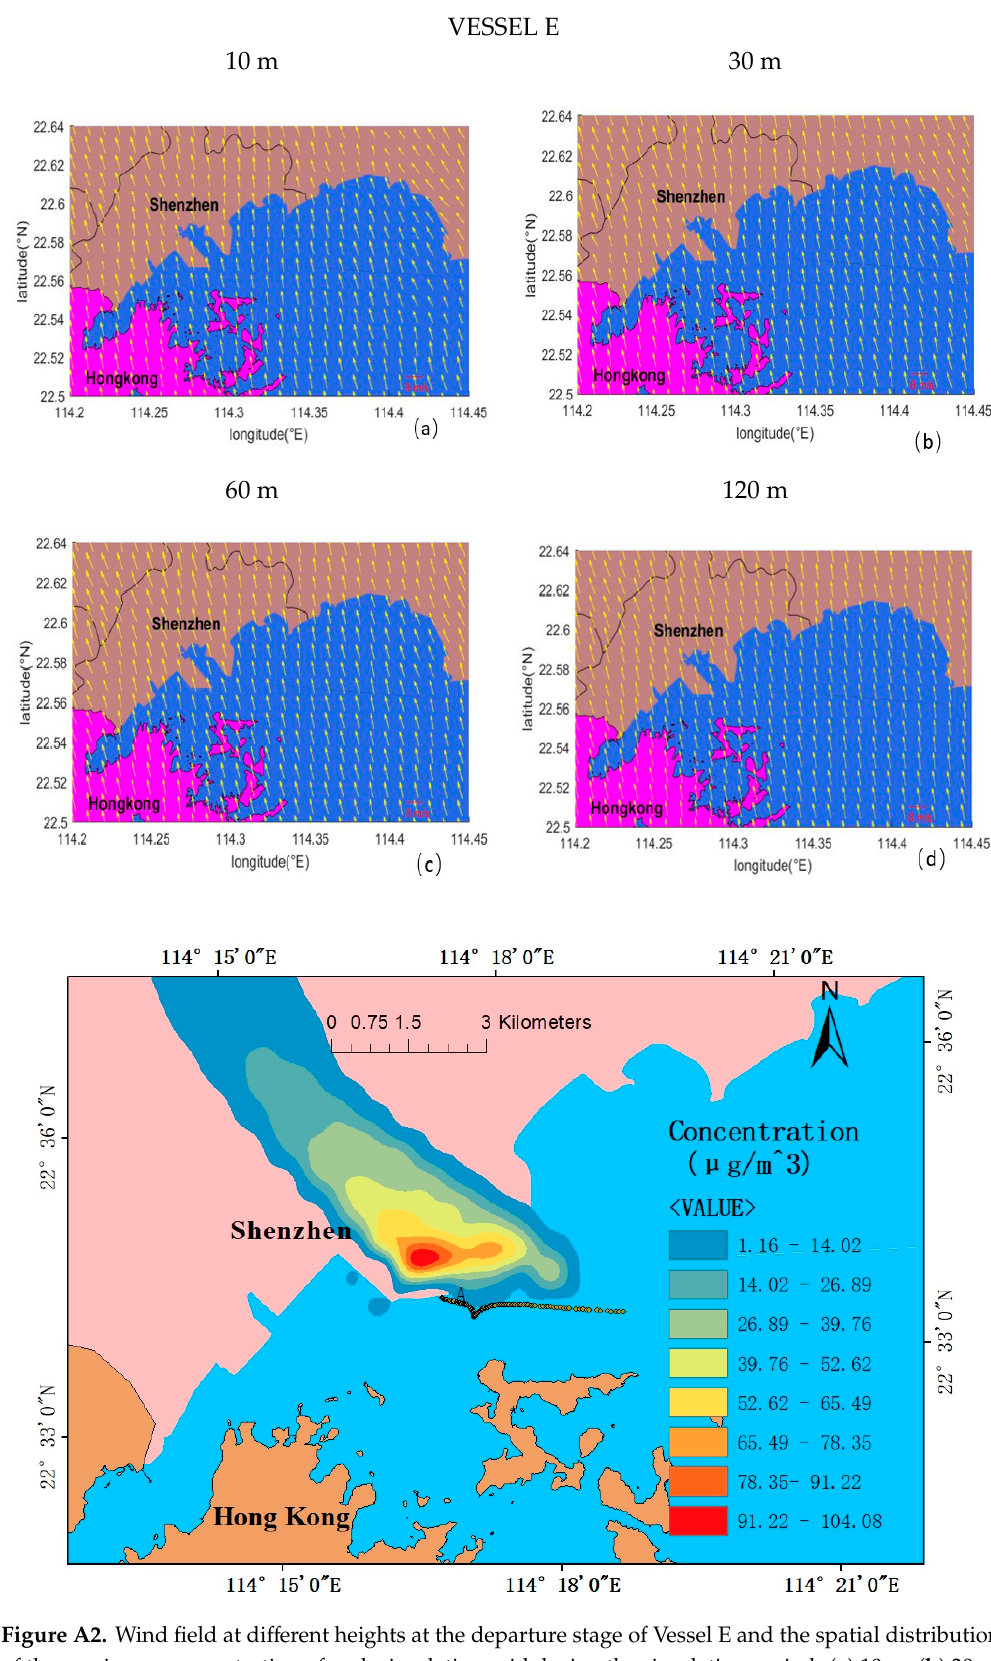
Figure A2. Wind field at different heights at the departure stage of Vessel E and the spatial distribution of the maximum concentration of each simulation grid during the simulation period. ( a ) 10m, ( b ) 30m, ( c ) 60m and ( d ) 120m.